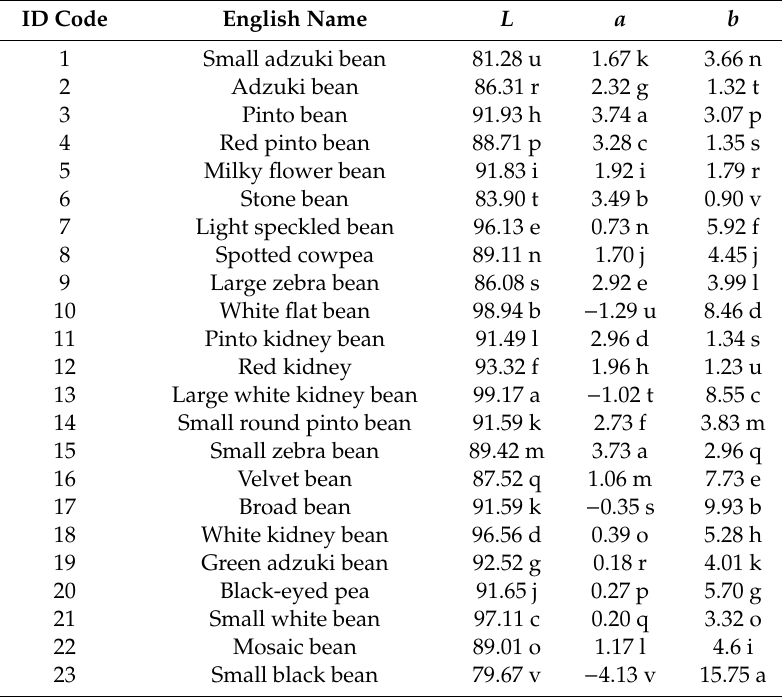
Table 2. Color value ( L , a , b ) of 23 food